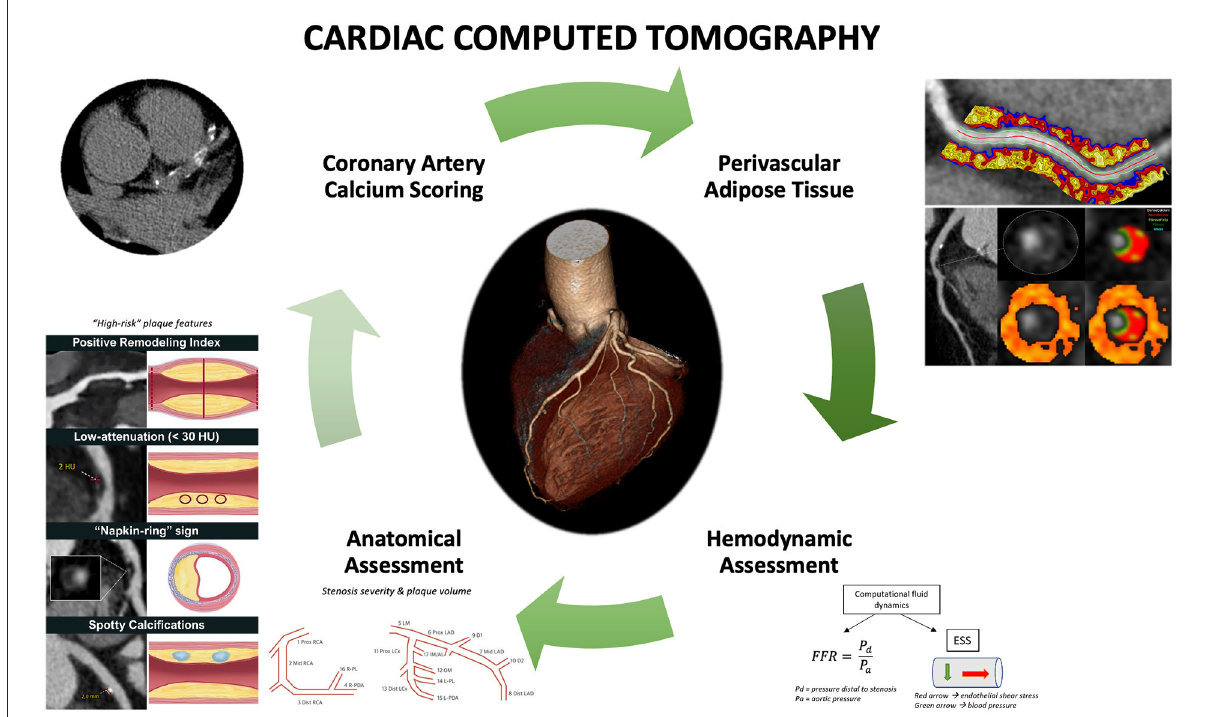
FIGURE1 Current and emerging roles of cardiac computed tomography in predicting adverse coronary events. Comprehensive assessment of coronary artery disease with cardiac computed tomography (CCT) includes coronary artery calcium score, anatomic assessment to identify stenosis, plaque volume, and high-risk plaque features, hemodynamic assessment using computational fluid dynamics to compute fractional flow reserve (FFR) and endothelial shear stress (ESS), as well as derivation of perivascular fat attenuation index. Perivascular fat attenuation index figure is owned by: Oxford Academic Cardiovascular CT Core Lab and Lab of Inflammation and Cardiometabolic Diseases at NHLBI, published under Attribution-NonCommercial 2.0 Generic (CC BY-NC 2.0). Link to license: